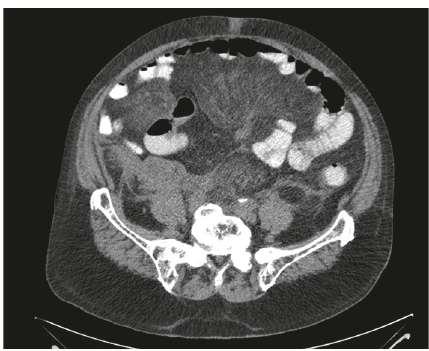
Figure 1: CT scan of the abdomen without contrast revealing mesenteric thickening with edema.